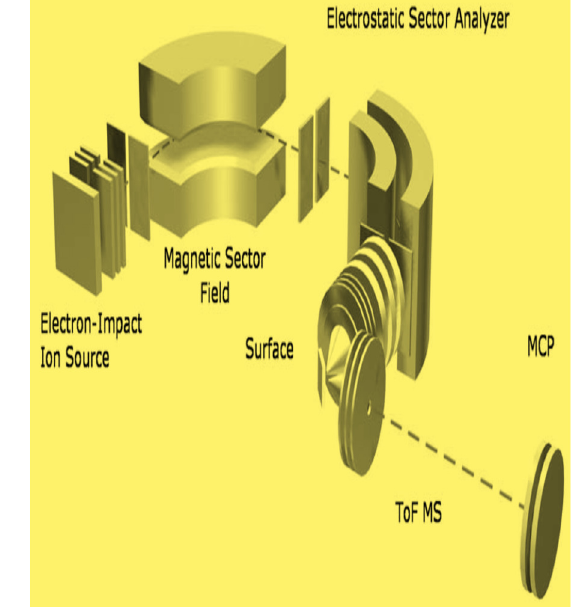
Fig. 1: SCHEME OF MASS SPECTROMETER